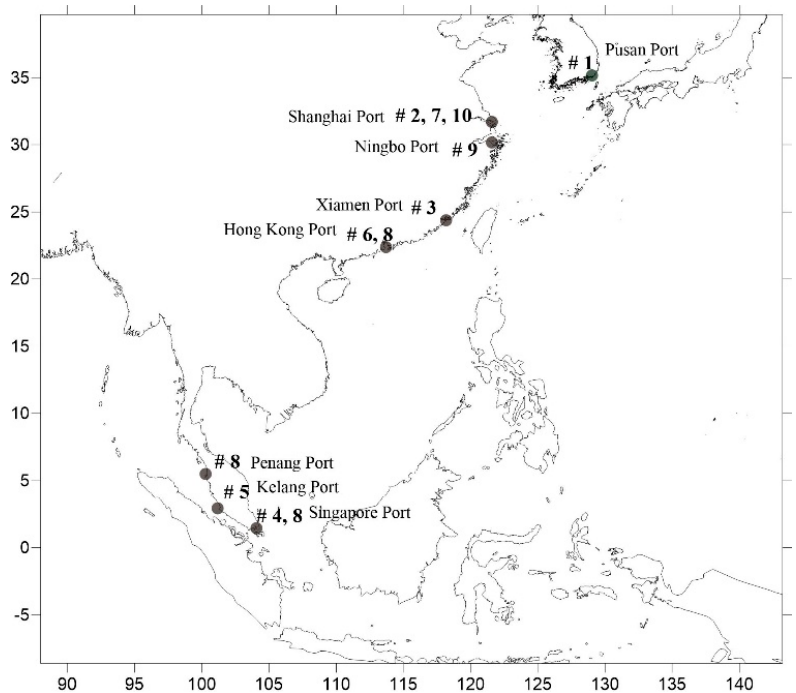
Figure 1. Ports where ballasting was conducted during shipboard tests of vessels having on